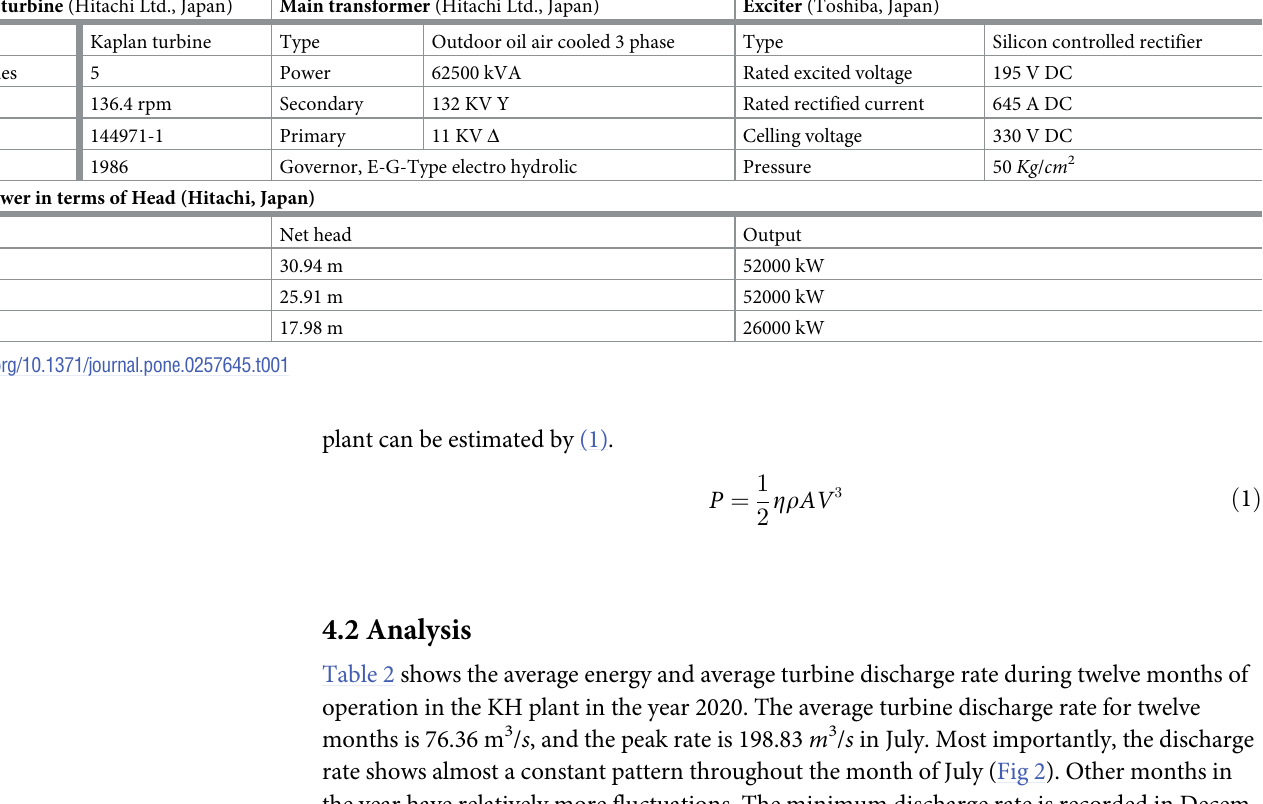
Table 1. Specification of installed turbine, transformer, exciter, governor in KH plant. Hydraulic turbine (Hitachi Ltd.,